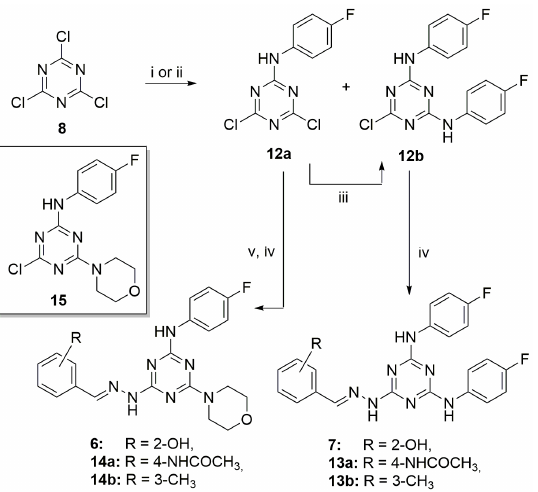
Table 1. Antiviral activity, cytotoxicity, and selectivity index of the synthesized compounds in vitro in a cell-based model 1